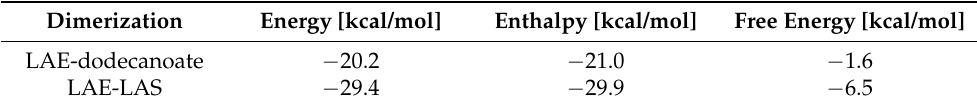
Table 3. Energies, enthalpies and free energies of formation of LAE heterodimers.